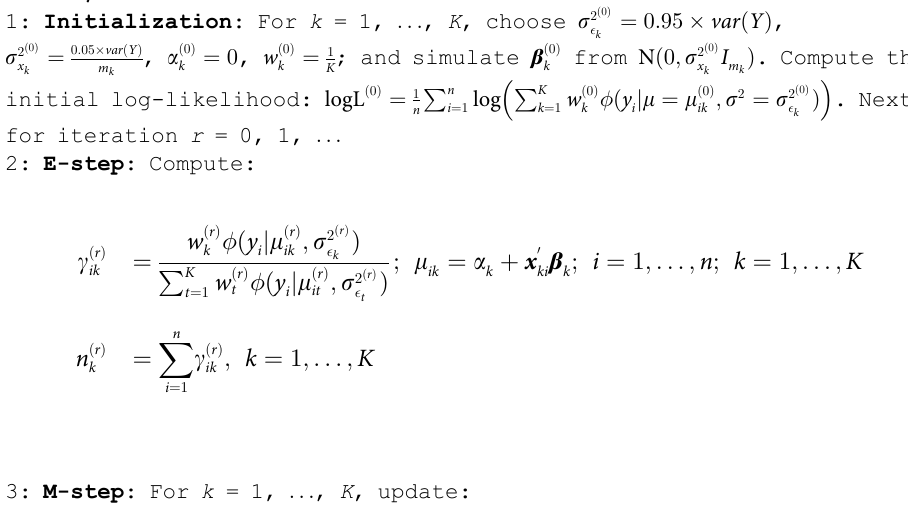
Algorithm 1 Maximum a posteriori (MAP) expectation maximization (EM) algorithm under Bayesian framework of the mixture